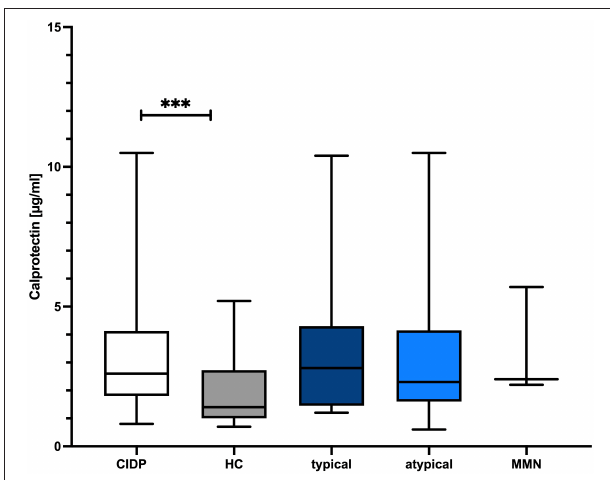
FIGURE 1 | Comparison of CLP level in CIDP and HC. The boxplot bar represents median (min.–max.) of serum calprotectin (CLP) level in all CIDP patients ( n = 63) and HC ( n = 40). Median CLP levels were significantly increased in all CIDP patients regardless of subtype ( p = 0.009) (typical: n = 31, atypical: n = 32, MMN n = 6). CIDP, chronic inflammatory demyelinating polyneuropathy; HC, healthy controls; min., minimum; max., maximum; MMN,